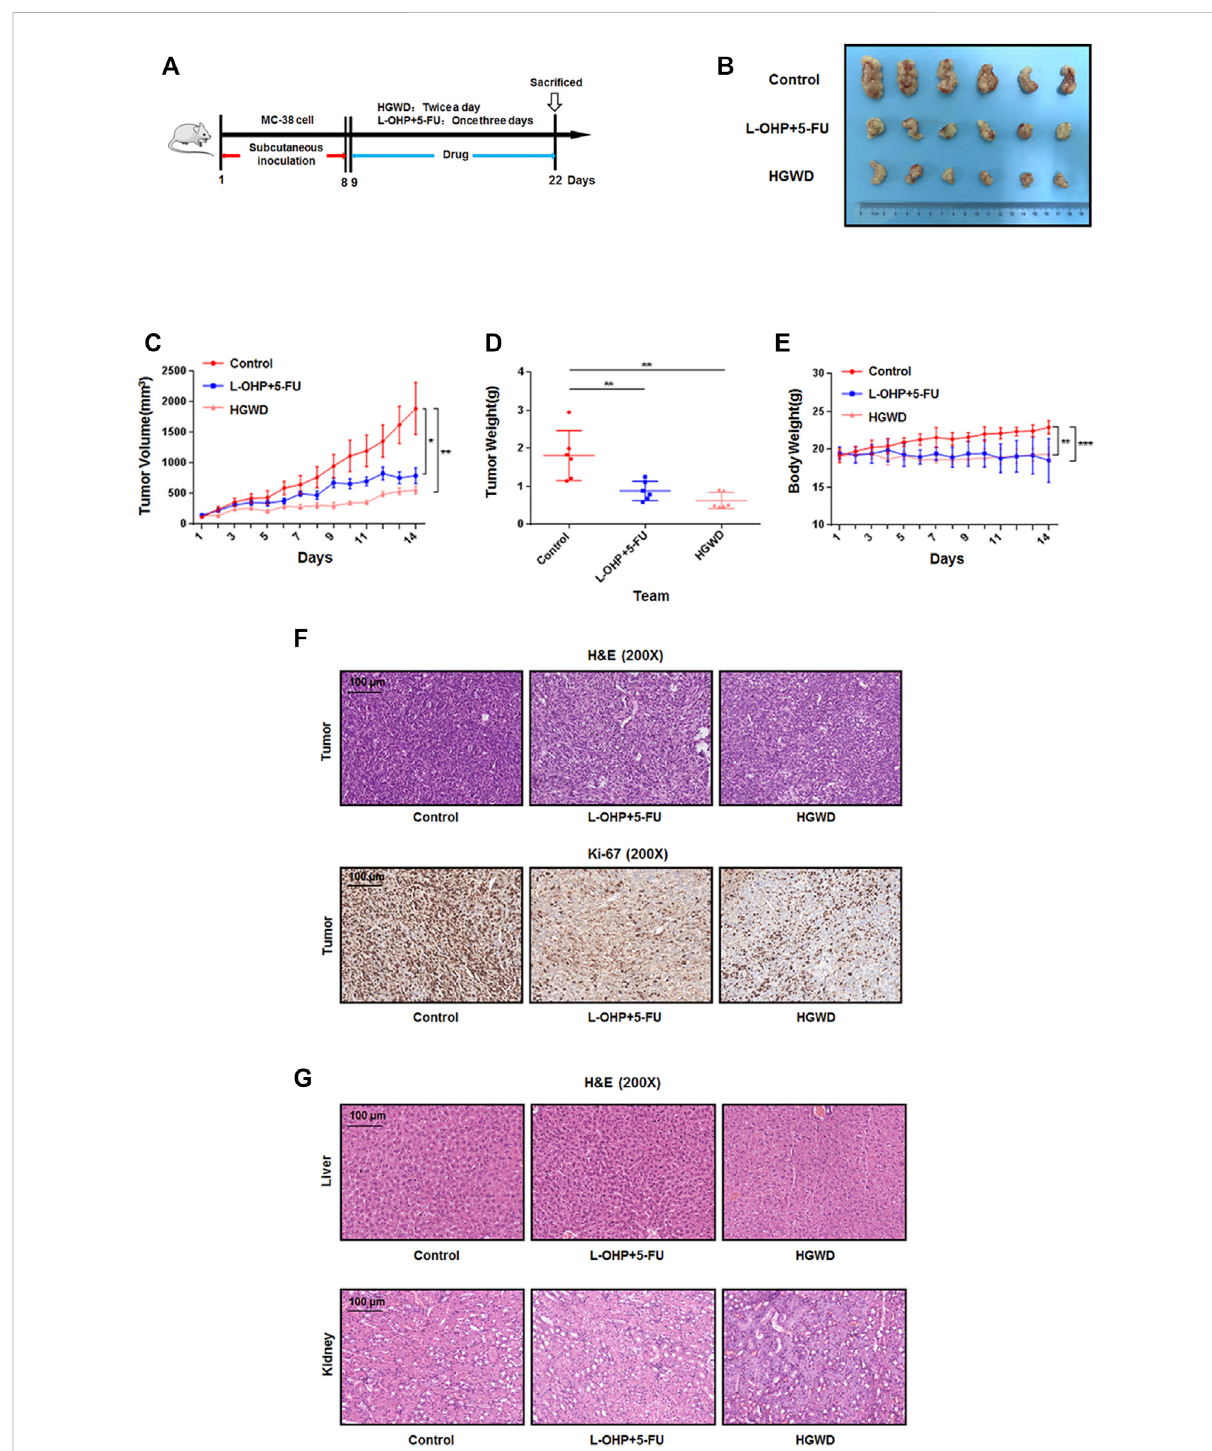
FIGURE 2 HGWDinhibitedthegrowthofxenograftedCCtumorsinC57BL/6mice (A) Work fl owforthis invivo analysis. (B) Imageoftumorsizesonday14. (C) Tumor volumes were evaluated once daily for 14 successive days. (D) Tumors were resected on day 14 and their weights determined. (E) Body weightsweredeterminedoncedailyfor14successivedays. (F) H&EandimmunohistochemistrystainingforKi-67weredoneusingtumorslidesfrom different groups. (G) H&E were performed by using the liver and kidney slides from different groups. * p < 0.05, ** p < 0.01 and *** p <